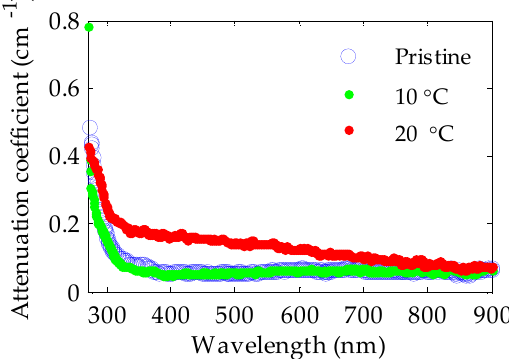
Figure 6. Attenuation coefficients measured for pristine PMMA POFs and for samples immersed in methanol at two different temperatures. At the temperature of 35 °C or above it the attenuation was too high for the measurements.